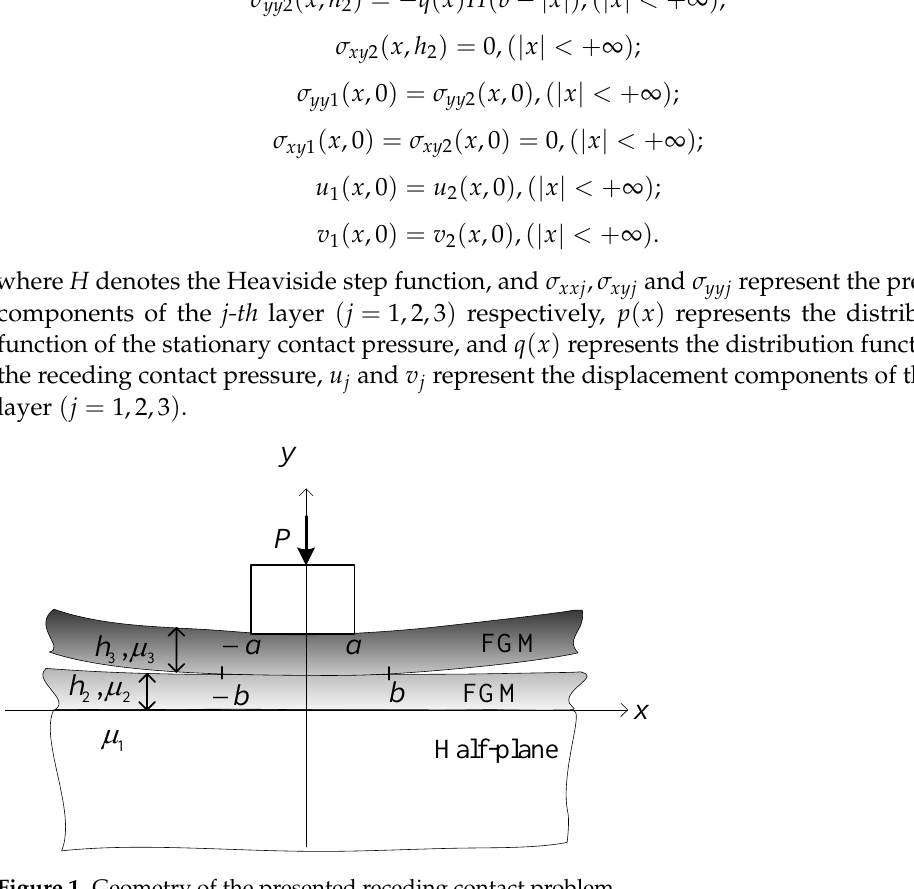
Figure 1. Geometry of the presented receding contact problem.